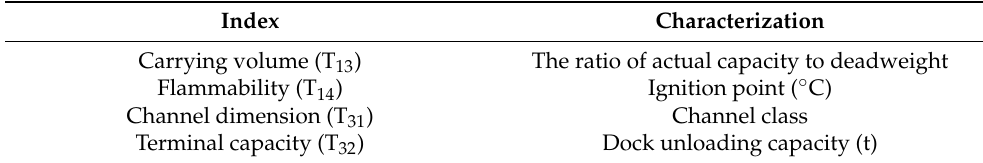
Table 6. Quantitative index grading basis.